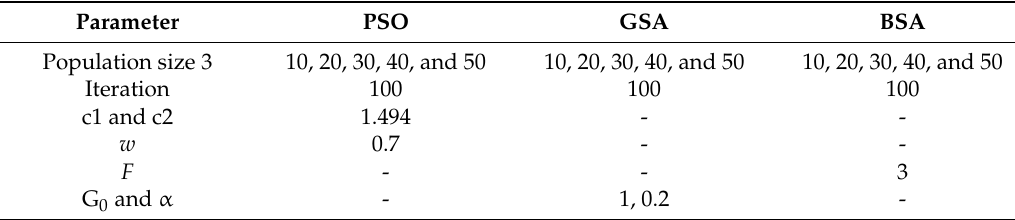
Table 1. Parameters of the heuristic